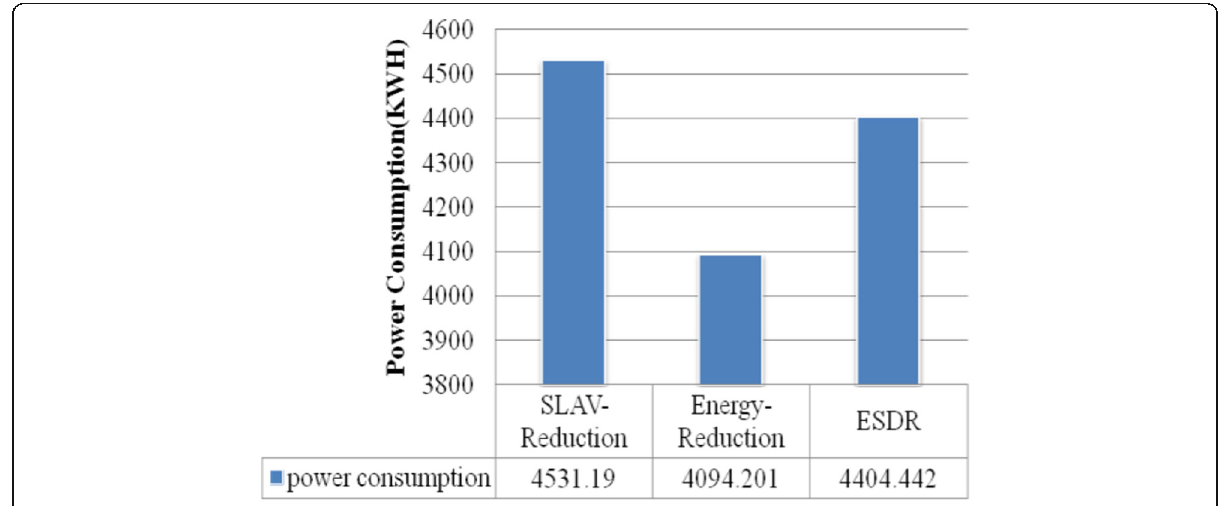
Fig. 2 Comparison of power consumption metric in different